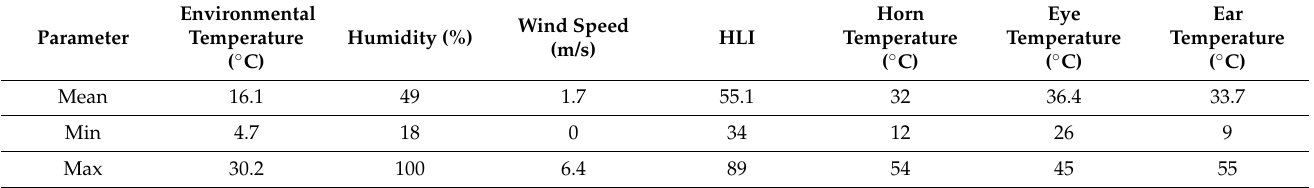
Table 3. A summary of the descriptive statistics for environmental temperature, humidity, wind speed, HLI, horn temperature, eye temperature, and ear temperature